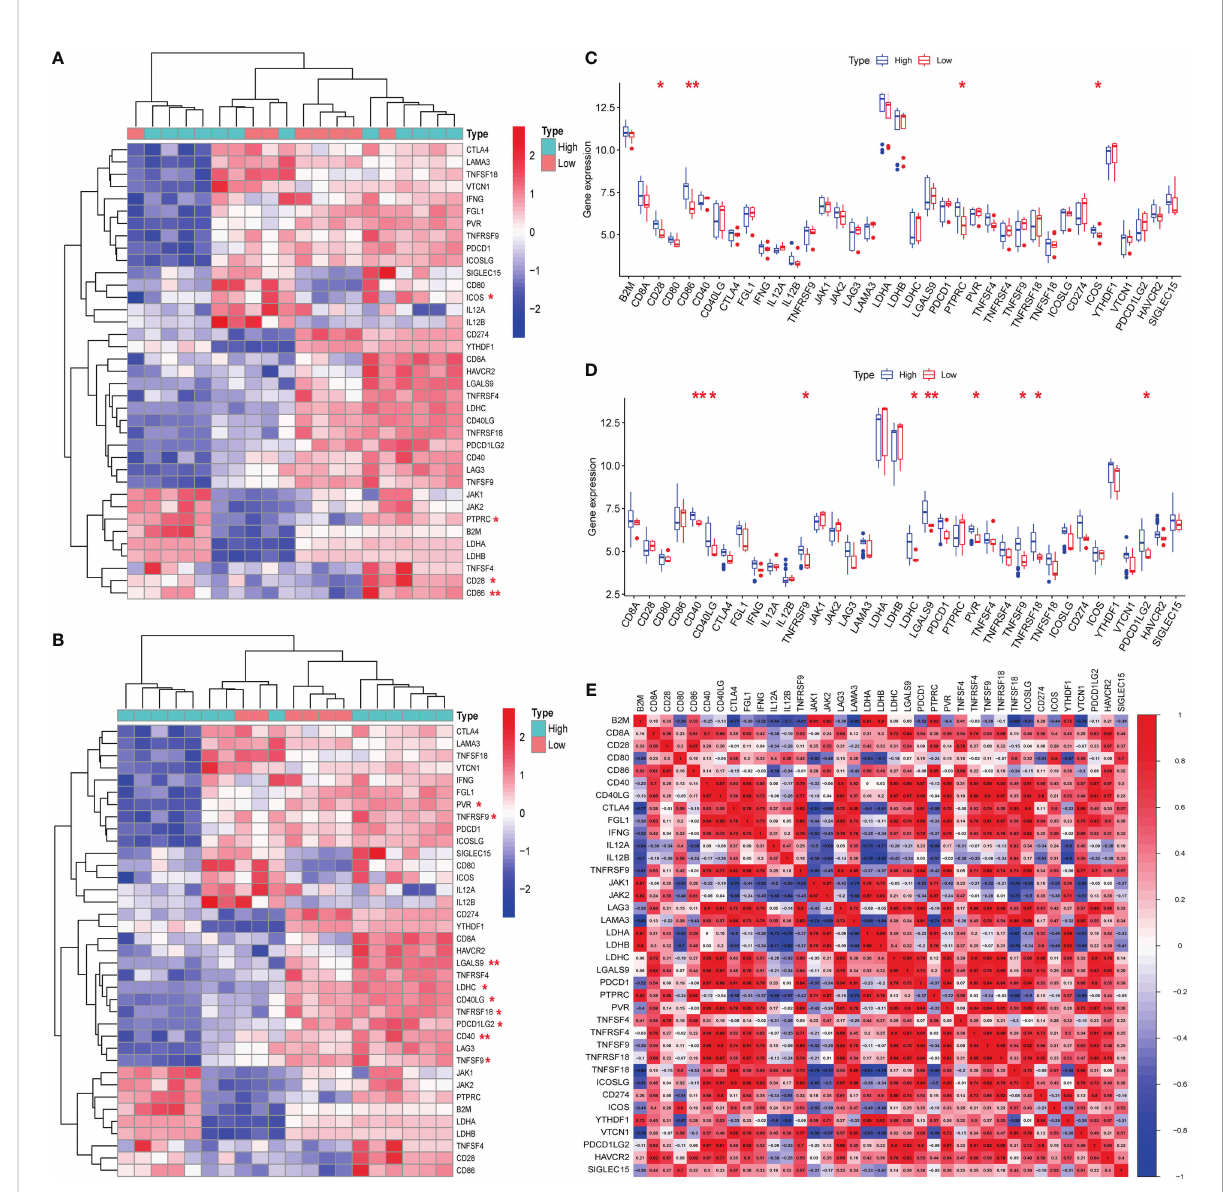
FIGURE 8 Expression of immune checkpoint-related mRNAs in calci fi c aortic valve disease (CAVD) patients. (A, B) Comparison of expression levels of 38 immune checkpoint-related RNAs. Immune checkpoint-related RNA expression between S100A8 / S100A9 high- and low-expression groups of patients. Blue represents high expression, whereas red represents low expression. (C, D) Visualization of differentially expressed immune checkpoint-related genes in CAVD. S100A8 / S100A9 high expression in CAVD patients is marked with blue, and S100A8/S100A9 low expression is marked with red. (E) Spearman correlation analysis of 38 immune checkpoint-related RNAs in CAVD. A higher number in the circle indicates a stronger correlation. The change in color on the right represents a positive or negative correlation. * P < 0.05, ** P < 0.01, *** P < 0.001 when two groups were compared as indicated or compared with the corresponding